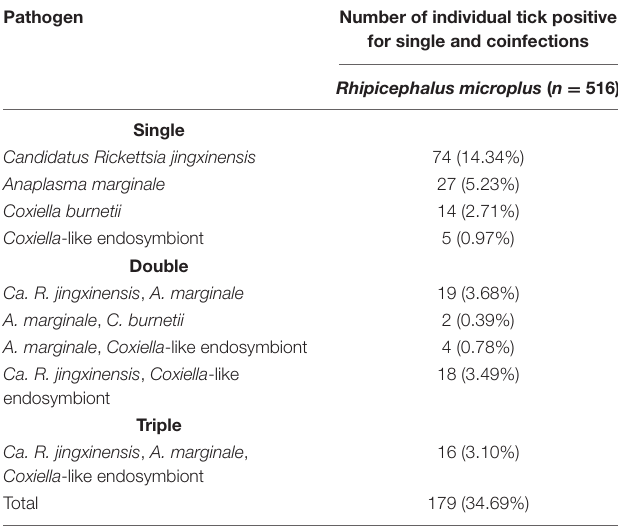
TABLE 2 | Prevalence of tick-borne pathogens in individual tick.